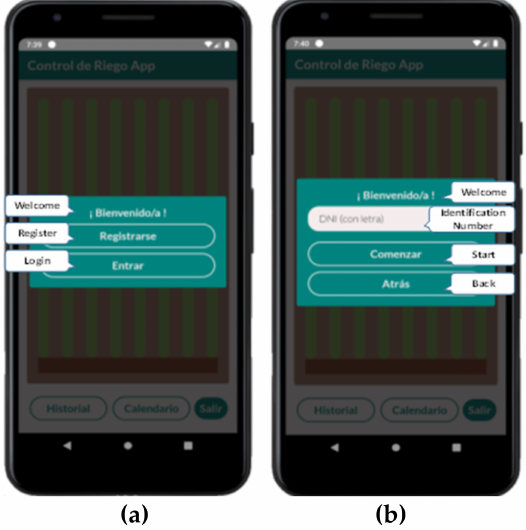
Figure 11. ( a ) Initial screen; ( b ) screen of login to access to the